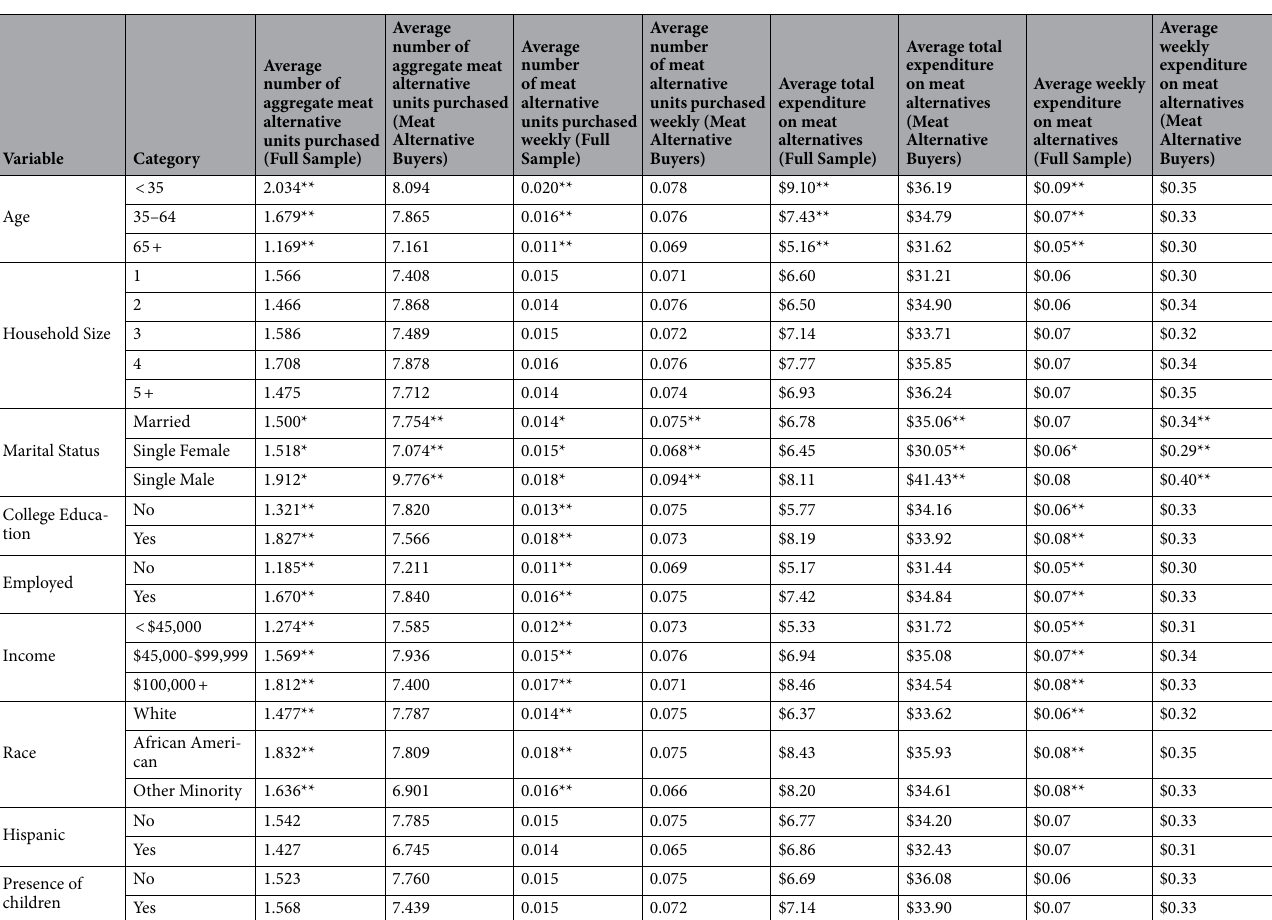
Table 3. Meat alternative units purchased and expenditure by demographic category. ANOVA tests were used to examine if the difference in mean values of each metric between demographic categories were different from 0. The sample used for the statistical test is denoted in parenthesis in the column description. A * denotes significance at the 5% level and ** denotes significance at the 1%